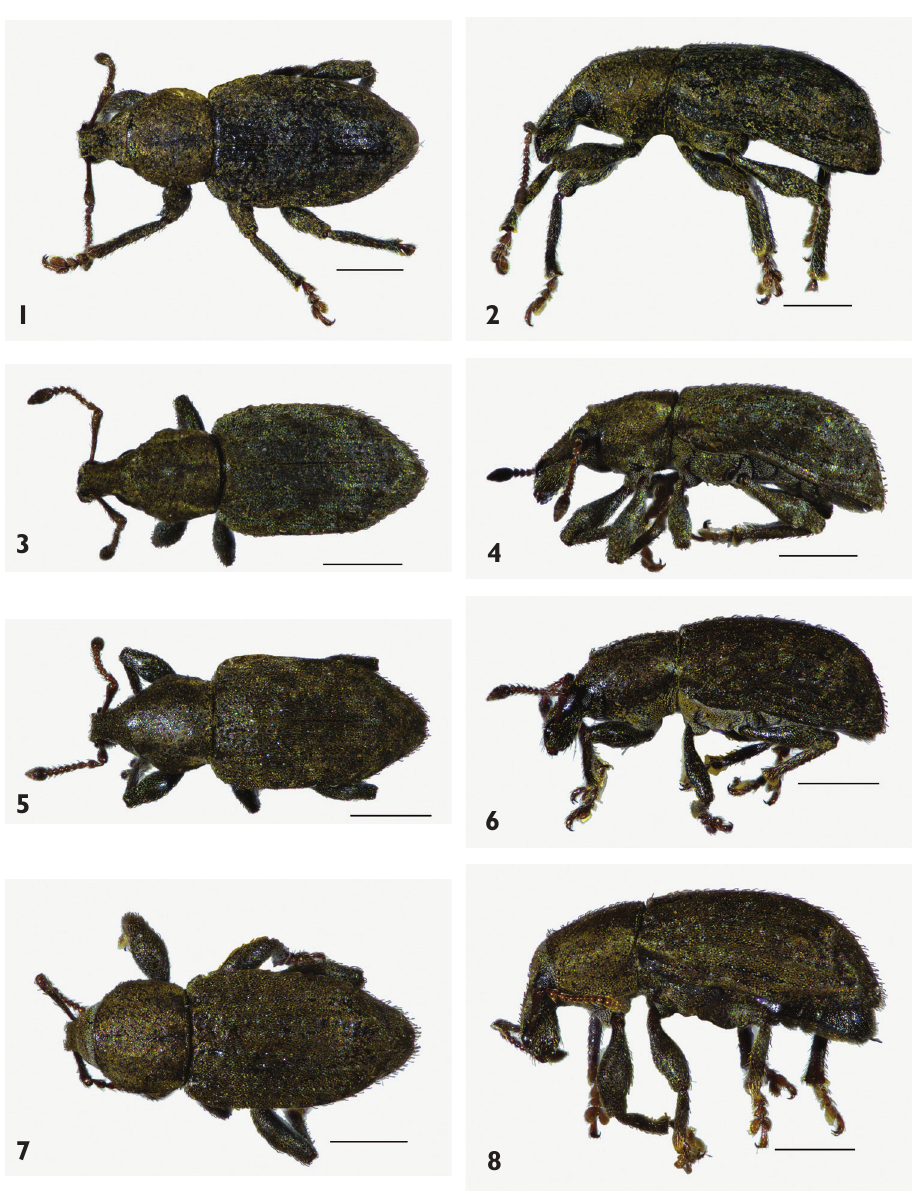
Figures 1–8. Habitus photographs of Austromonticola males. 1, 2 A. atriarius 3, 4 A. mataura 5, 6 A. furcatus 7, 8 A. rotundus . Scale bars = 1